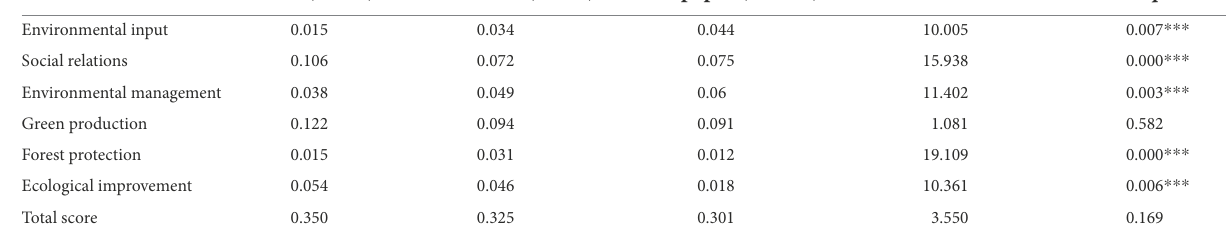
TABLE 8 Industry comparison of forestry CEER.